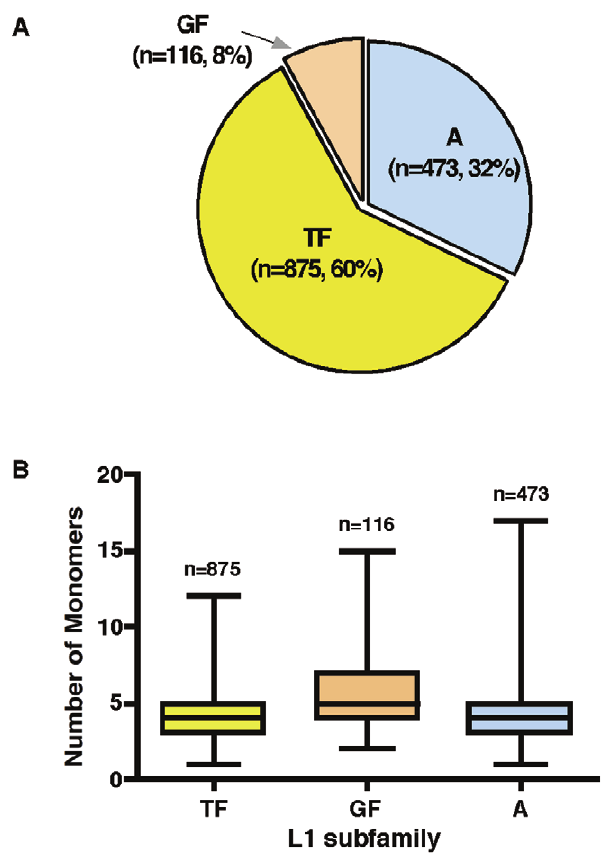
Figure 1. Identification of potentially active L1 elements in the mouse genome sequence (UCSC mm8) based on their mono- mer sequences of subfamilies. ( A ) A total of 1,464 active L1 elements were analyzed and the distribution of three main L1 subfamilies T F , A, and G F is shown. The T F subfamily is considered as the youngest active elements. Subfamily F and unclassified L1 elements were removed from the data analysis. ( B ) The average number of monomers present in each subfamily of L1 5 9 -UTR promoters. Boxplots show the average length of monomers and standard deviation representing the varying length of monomers. The longest monomer in the T F subfamily is 12, followed by 15 and 17 monomers for G F and A subfamilies,